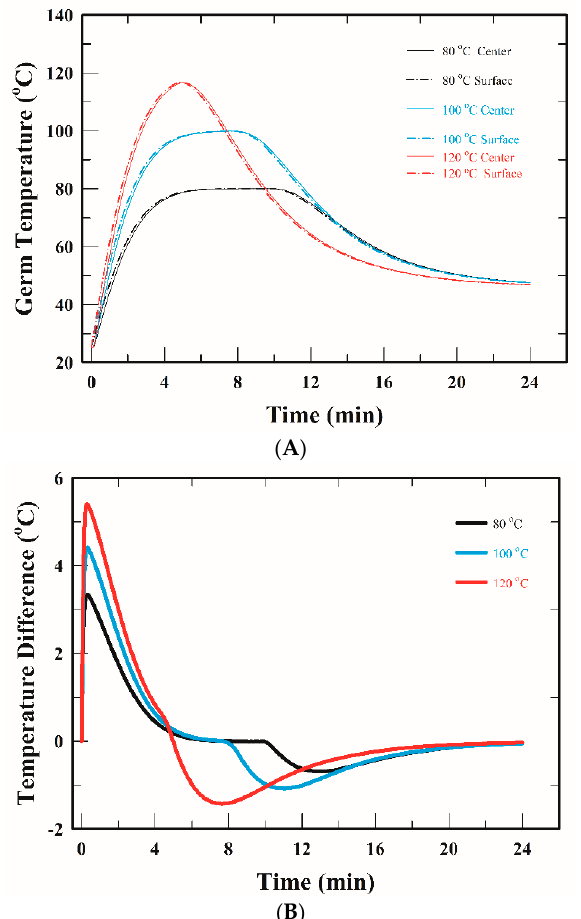
Figure 9. Simulated profiles of the temperature distribution ( A ) and the temperature difference ( B ) of WG during drying at different set temperature in the FBD. Solid lines represent the WG center; dash-dot lines represent the WG surface.